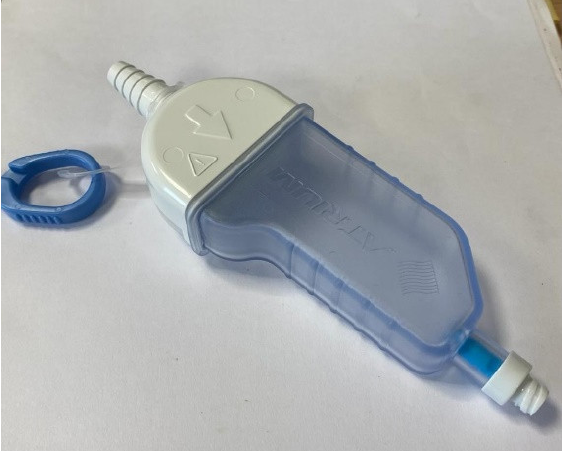
Figure 2. An Atrium Pneumostat—one-way flutter valve.